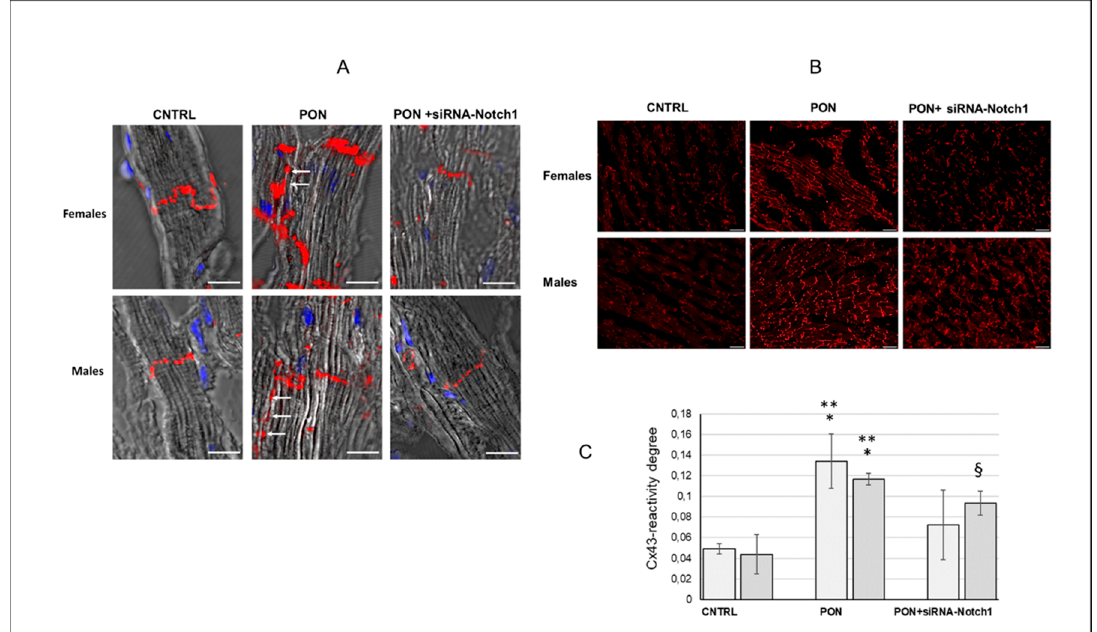
Figure 4. Cx43 protein expression at cardiomyocyte membrane level. ( A ) Confocal laser scanning microscopy: representative three-dimensional images of the maximum intensity projection of mice cardiomyocyte longitudinal sections. Cx43 (red) is confined at the intercalated discs in CNTRL and in siRNA-Notch1 groups whereas it lies also on the lateral border (arrows) of cardiomyocytes (grey) in PON groups. Nuclei of cardiomyocytes and connective cells are marked with DAPI in blue. Magnification: 600×. Bars: 10 µm. ( B ) Immunofluorescence staining: representative images of Cx43 immunoreaction (red). Magnification: 200×. Bars: 50 µm. ( C ) Image analysis of Cx43-immunofluorescence on cardiomyocytes. Data are expressed as mean ± standard deviation, n = 4. * p < 0.001 vs. CNTRL; ** p < 0.05 vs. PON + siRNA-Notch1; §: p < 0.001 vs. CNTRL.